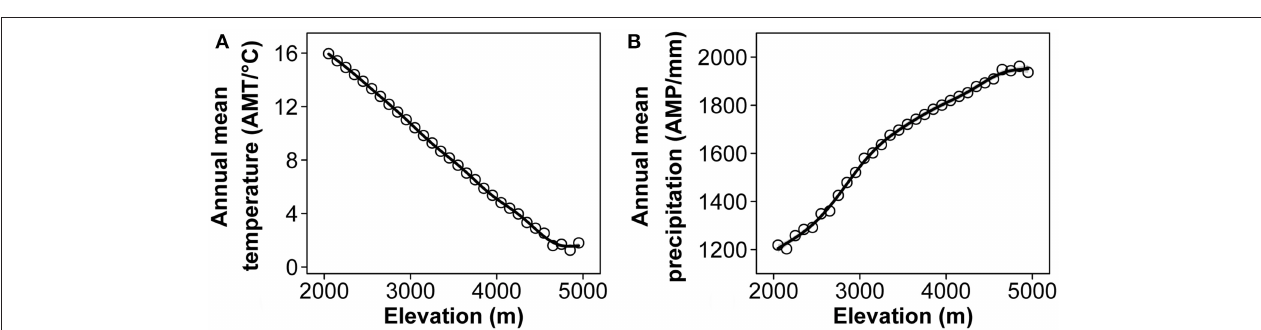
FIGURE 1 | An elevation map of Mount Kenya showing 100-m vertical elevation bands. The black solid line shows the elevation of 2,000m a.s.l..